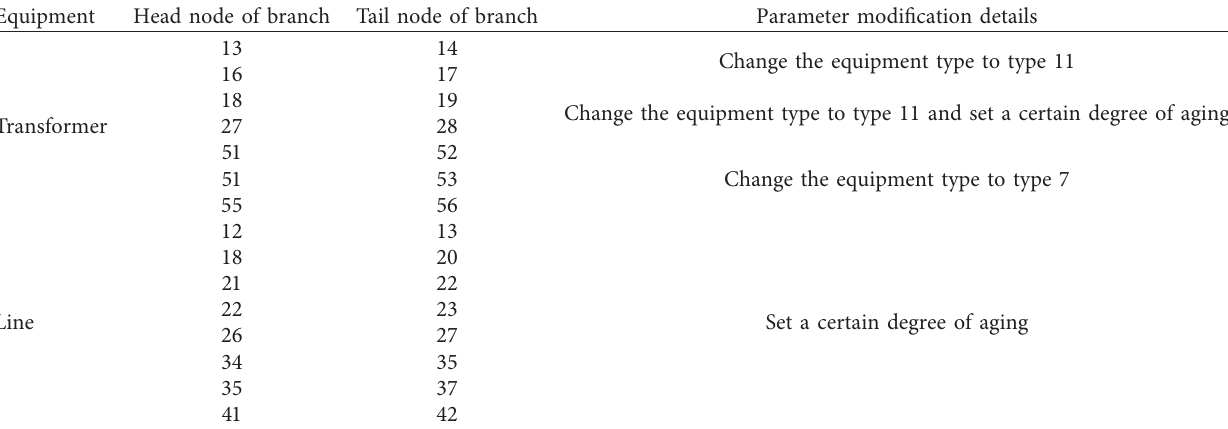
Table 1: Parameter modification details of transformers and